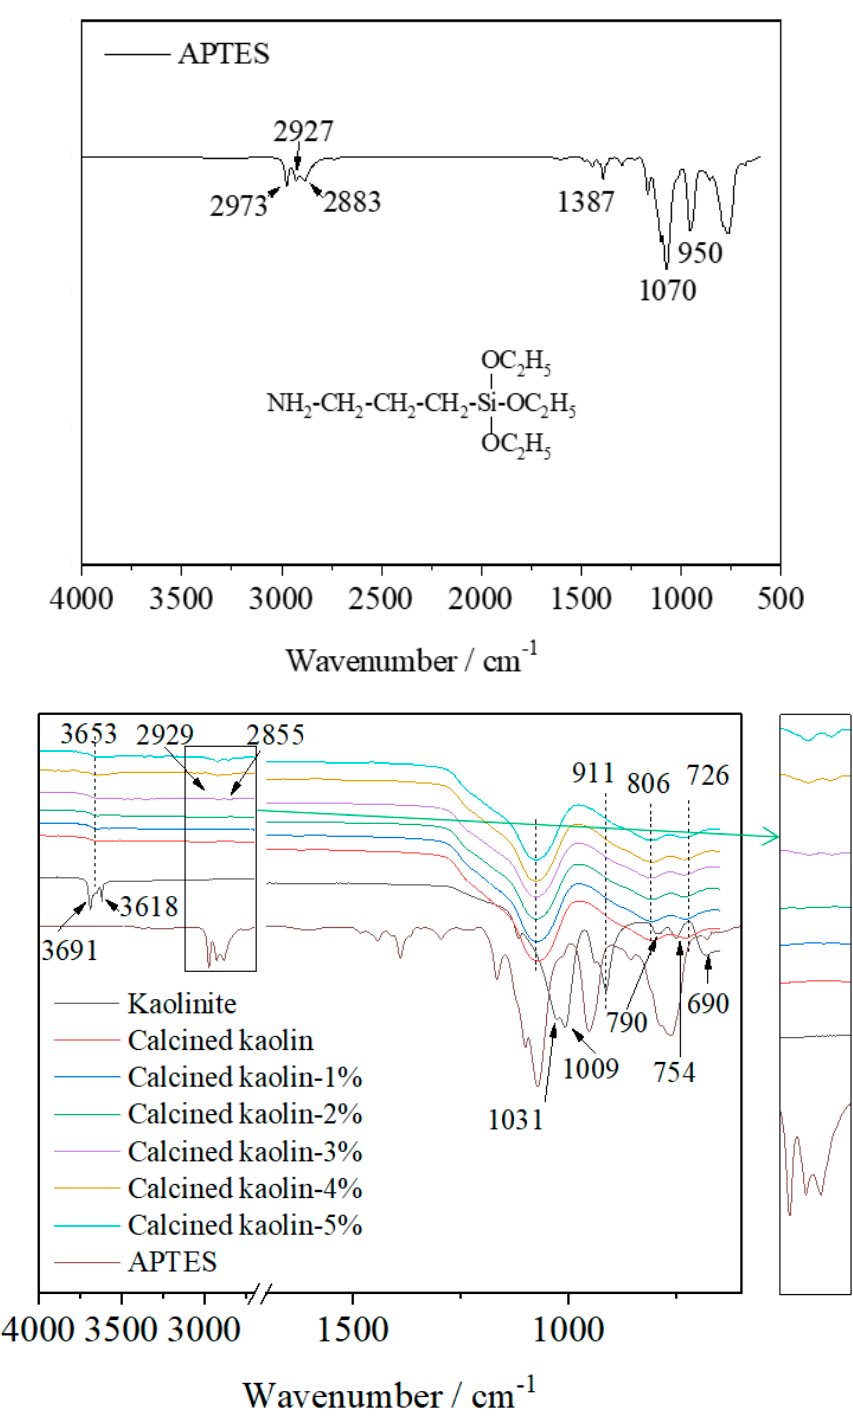
Figure 4. FT-IR spectra of all samples ( up : APTES; down : kaolinite, calcined kaolin, and modified calcined kaolin). calcined